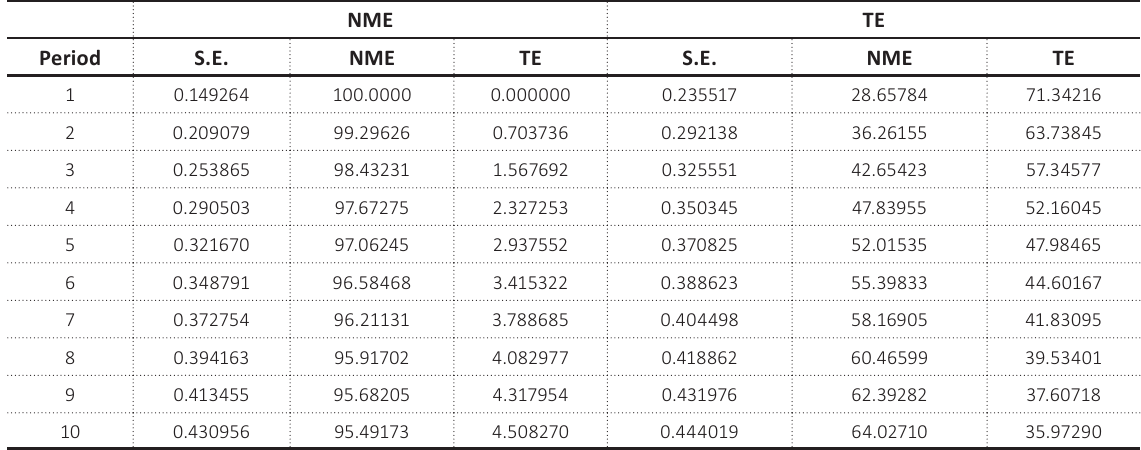
Table 6. Variance